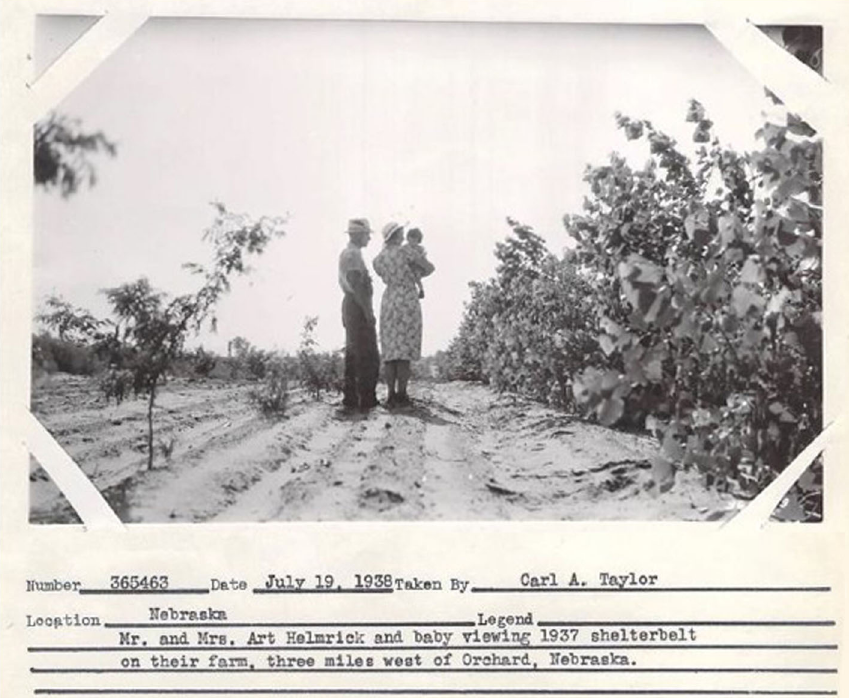
Fig. 4 Archival Source Photography. Mr. and Mrs. Art Helmrick and baby viewing a 1937 shelterbelt on their farm (photo taken in 1938). (Source: National Agroforestry Centre – Forest